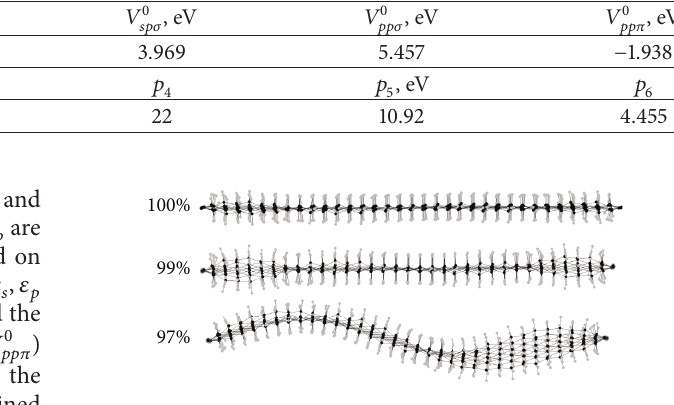
Figure 1: The change of graphane nanoflake structure under compression deformation.